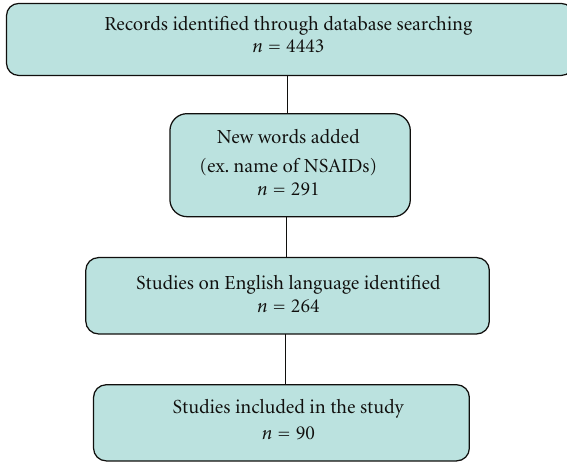
Figure 2: Flow chart diagram of included